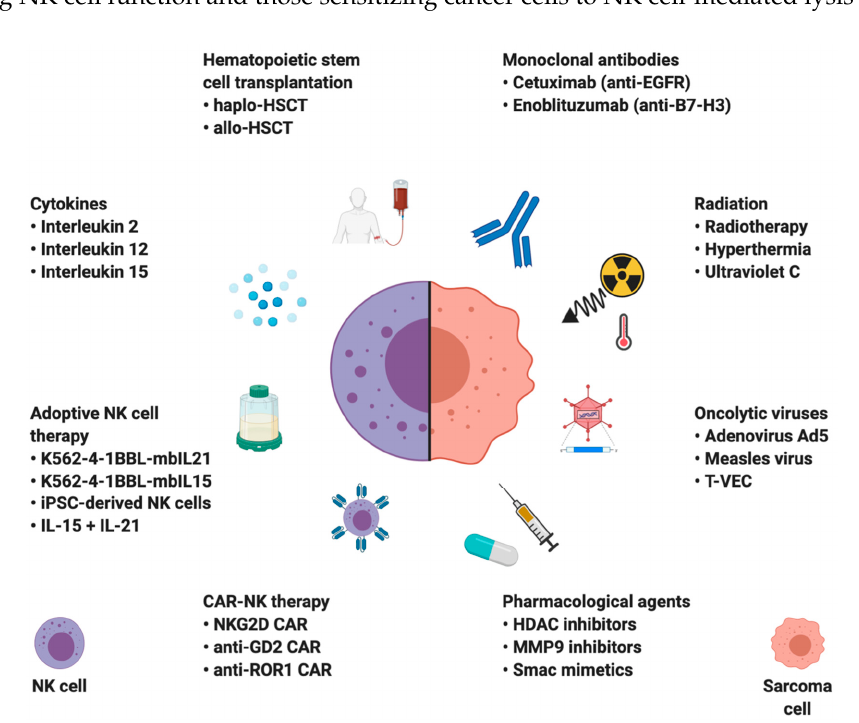
Figure 3. A schematic illustration of selected prospective sarcoma treatment modalities based on: modifying natural killer (NK) cell properties (left); or sensitizing sarcoma cells to NK cell cytotoxicity (right). Created with BioRender.com.